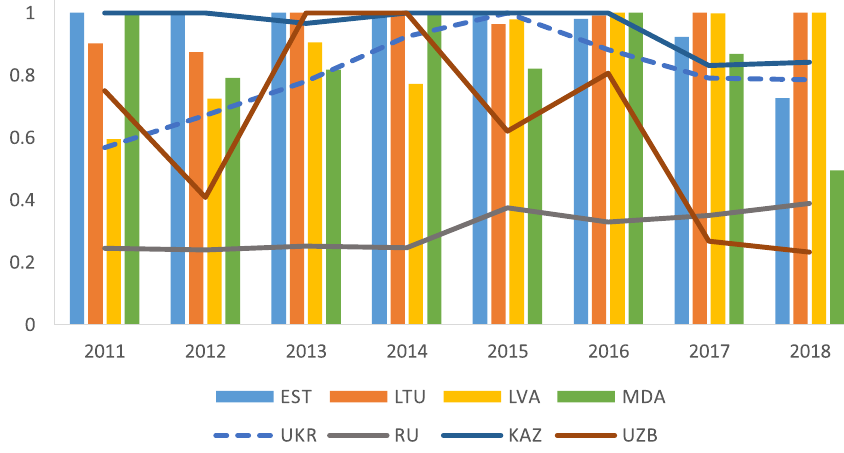
Figure 9. Efficiency scores of NISs, 2011–2018.